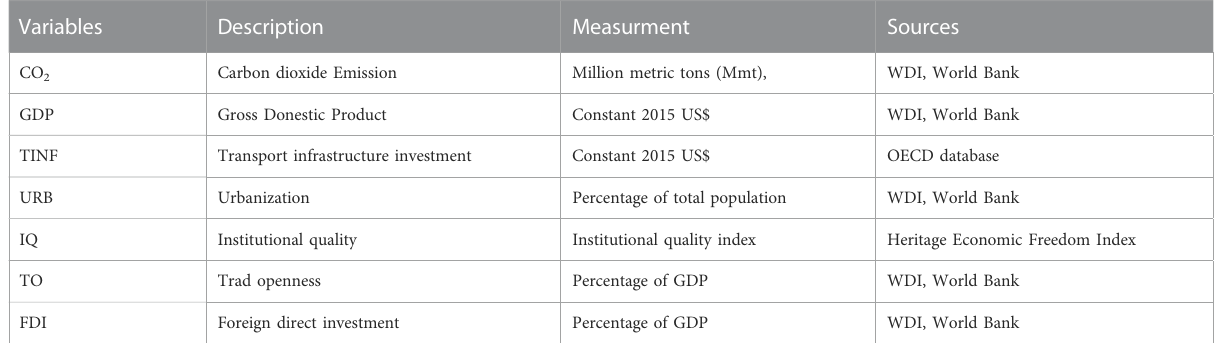
TABLE 1 Description, measurement and data sources of variables.